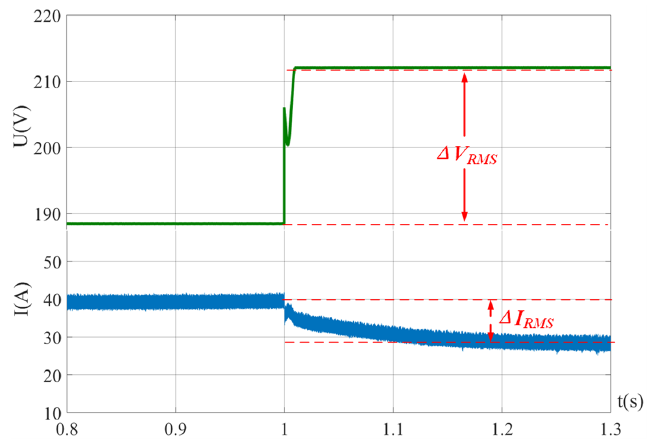
Figure 2. The RMS voltage and current of an AC CPL. The energy storage system is connected to the AC bus through a bidirectional DC-DC converter and a DC-AC converter. Figure 3 depicts the process that is used to regulate the DC-DC converter. To keep the DC voltage constant, the DC-DC converter has two PI control loops. It consists of voltage outer-loop control and current inner-loop control, respectively. Both the charging and discharging states are selected arbitrarily by the system. If v dc < v dcref , the energy storage system will discharge. On the other hand, if v dc > v dcref ,